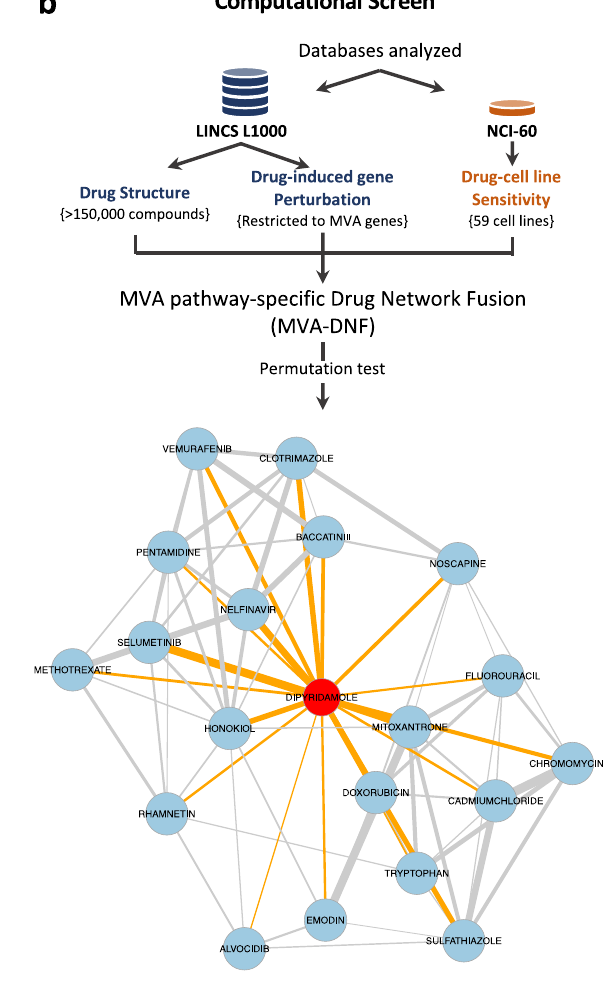
Fig. 1 | A schematic of the mevalonate (MVA) pathway and overview of the computational pharmacogenomics work fl ow. a In response to fl uvastatin treatment (labeled with 1), MVA pathway end-product levels decrease, triggering an SREBP-mediated feedback response that activates MVA pathway-associated gene expression to restore cholesterol and other non-sterol end-products. Dipyr- idamole (DP) (labeled with 2) blocks the SREBP-mediated feedback response, thereby potentiating fl uvastatin-induced cancer cell death. b An overview of the computational pharmacogenomics work fl ow, MVA-DNF, was used to identify the top 19 compounds and visualized as a compound network. MVA-DNF combines drug structure, drug-induced gene perturbation datasets restricted to six MVA pathway-speci fi c genes, and drug sensitivity. Permutation speci fi city testing was performed to select compounds that have a degree of speci fi city to the MVA pathway and dipyridamole. Statistical signi fi cance of compounds similar to